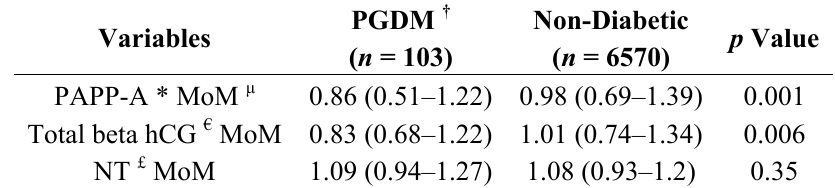
Table 2. Comparison of first trimester analytes between PGDM and non-diabetics.